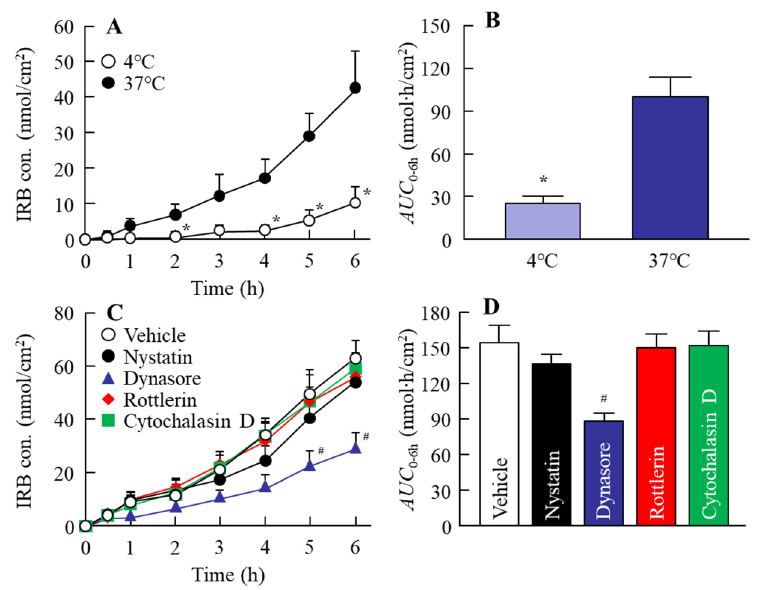
Figure 6. Changes in intestinal penetration of the IRB-NP tablet (Rp.8) through inhibition of endo- cytosis. ( A ) Penetration profile and ( B ) AUC 0–6 h of IRB in the IRB-NP tablet under cold (4 °C) and normal (37 °C) conditions. IRB-NP tablet-treated intestine at 4 °C. IRB-NP tablet-treated intestine at 37 °C; ( C ) drug penetration profile and ( D ) AUC 0–6 h of IRB in the intestines of rats co-treated with an IRB-NP tablet and endocytosis inhibitors. Vehicle, intestine co-treated with 0.5% DMSO, and an IRB-NP tablet. Nystatin, intestine co-treated with nystatin and an IRB-NP tablet. Dynasore, intestine co-treated with dynasore and an IRB-NP tablet. Rottlerin, intestine co-treated with rottlerin and an IRB-NP tablet. Cytochalasin D, intestine co-treated with cytochalasin D and an IRB-NP tablet. n = 6–9. * p < 0.05 vs. 37 °C for each category. # p < 0.05 vs. the vehicle for each category. The dynasore prevented intestinal penetration of the IRB-NP tablet.